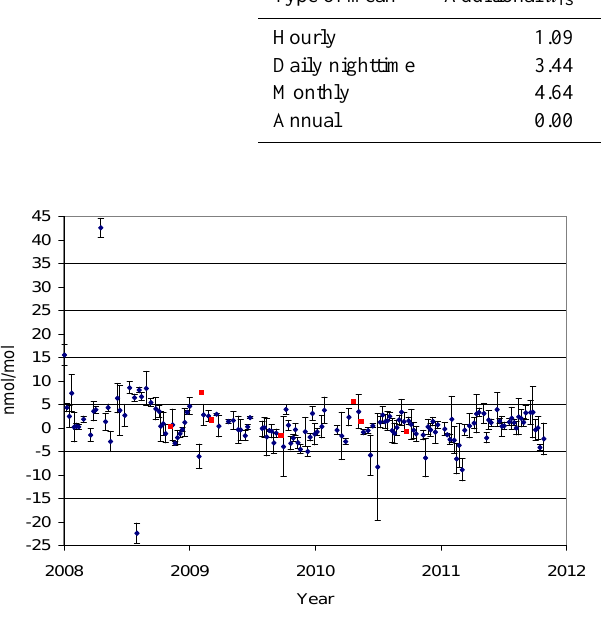
Fig. 6. Differences between NOAA flask samples and simultaneous in situ hourly means. Error bars indicate the comparison uncertainty. Differences plotted in red do not have associated uncertainty due to the presence of only one ambient air injection within the associated